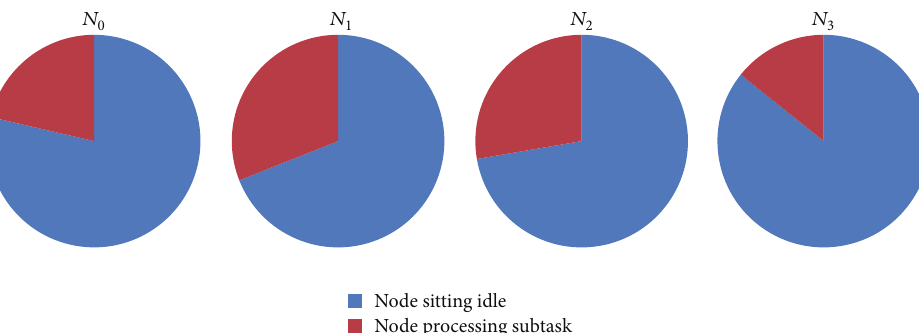
Figure 14: Utilization of P2P nodes in random scheduling.